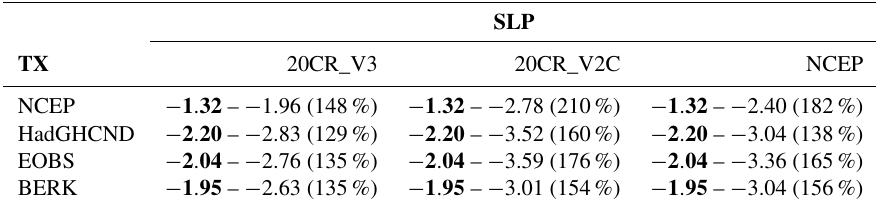
Table 1. Total TX anomaly ( ◦ C, in bold) and dynamic component contribution ( ◦ C and as a fraction of the total anomaly in percent) averaged over Europe (36–72 ◦ N, 10 ◦ W–30 ◦ E, black box in Fig. 1c) during the 2009–2010 winter cold spell. The reference period is 1981–2010.